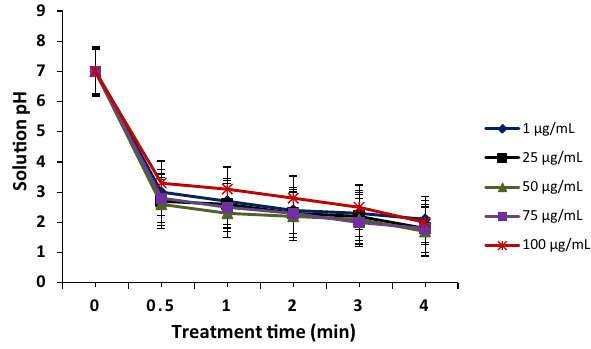
Fig. 8 pH variation of caffeine aqueous solutions with different caf- feine concentrations on DBD plasma treatment. Initial pH of solu- tions: 7; volume of sample: 20 mL and input power: 60 W